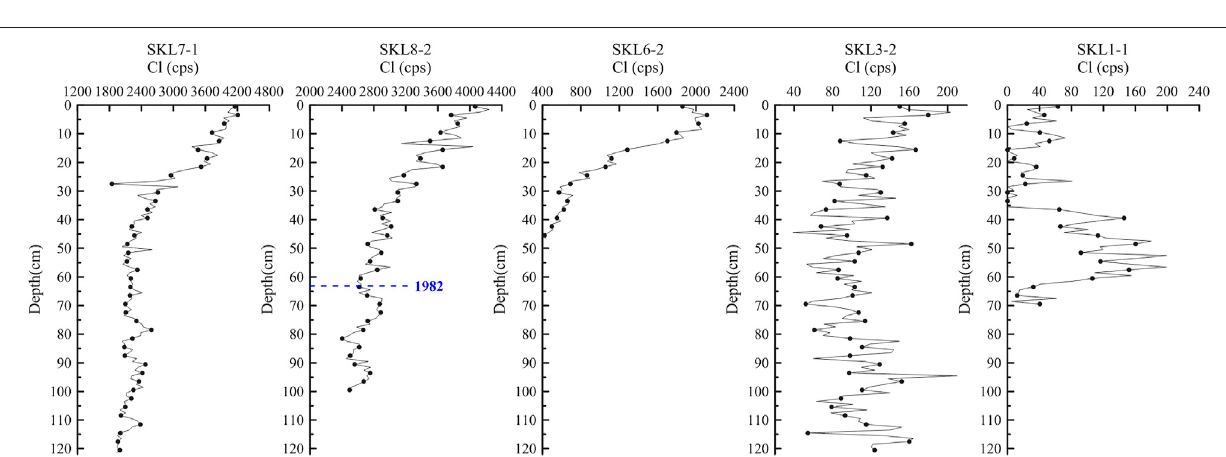
Frontiers in Earth Science |